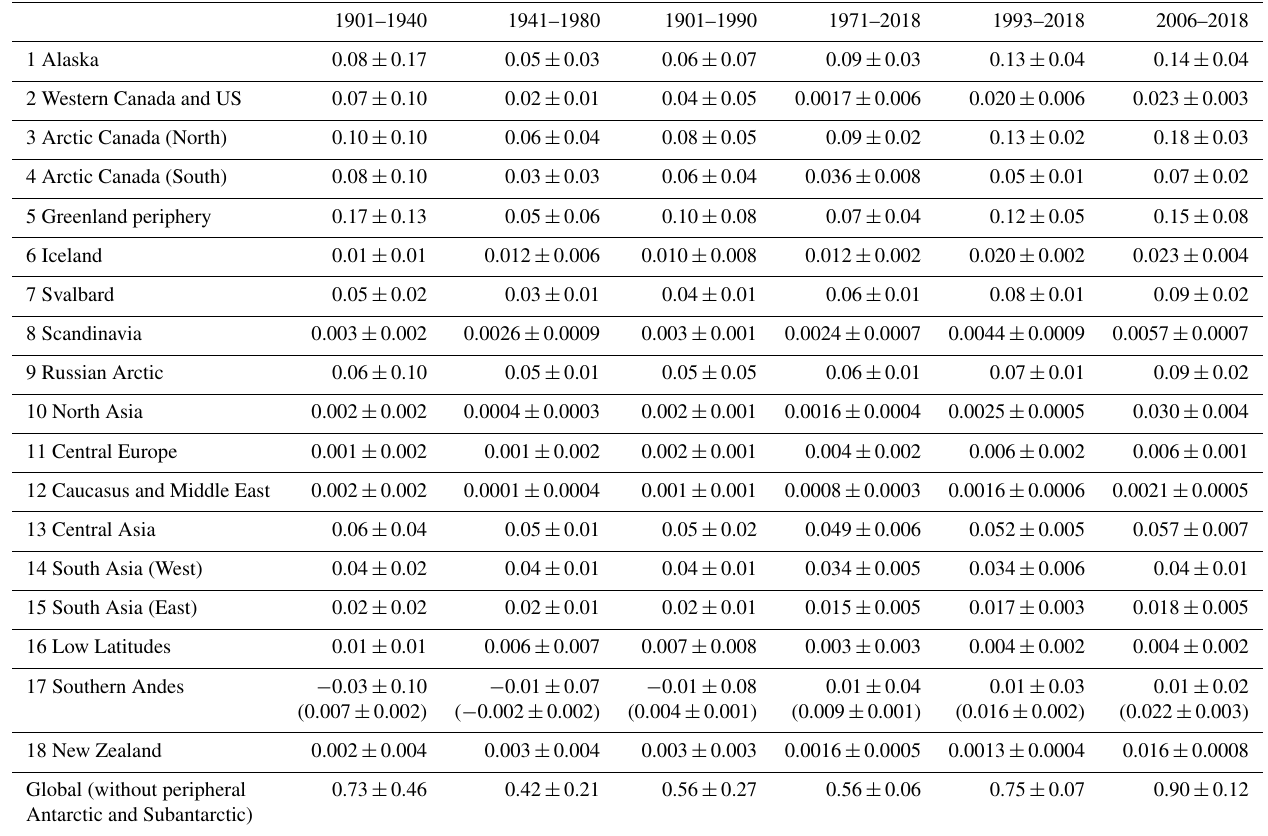
Table 3. Ensemble mean regional mass change rate estimates (in mmSLEyr − 1 ) for 18 primary RGI regions over different time periods. Results of the CERA20C forcing are excluded from the ensemble mean (see Sect. 3.1.1). Values in brackets for the Southern Andes exclude 20CRV3 results (see Sect.